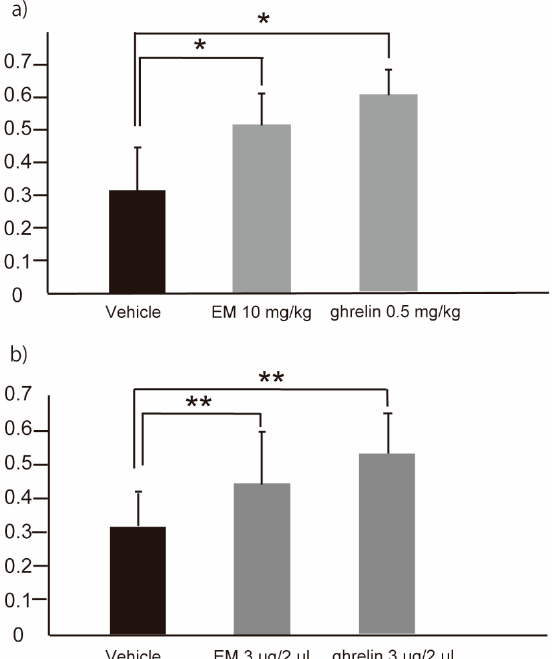
Figure 3. Gastric emptying of human MLNR Tg mice following peripheral (intraperitoneal) administration of EM ( n = 6) or ghrelin ( n = 3) ( a ), or following central (intracerebroventricular) administration of EM ( n = 14) or ghrelin ( n = 9) ( b ). Values represent the mean ± SD for the indicated number of animals. * p < 0.05, ** p < 0.01 (One-way ANOVA with Tukey post-hoc test).